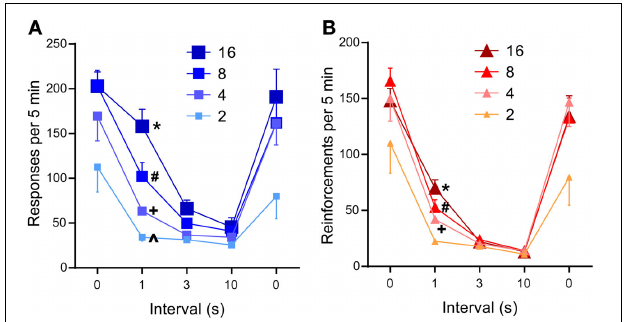
FIGURE 5 | Effects of inter-reinforcement interval on self-stimulation. (A) Mean lever-press rates are shown as a function of inter-reinforcement interval and pulse number. All 0-s interval values were significantly greater than respective 3- or 10-s interval values ( Ps < 0.001). * P < 0 . 001, significantly greater than its 3- and 10-s values, but not from its 0-s value; # P < 0 . 05, significantly greater than its 3- and 10-s values, but lower than its 0-s value; + , ∧ P < 0 . 001, not significantly different from its 3- and 10-s values, but lower than its 0-s value (B). Mean reinforcement rates are shown as a function of reinforcement interval and pulse number. All 0-s interval values were significantly greater than respective 1-, 3-, or 10-s interval values ( Ps < 0.001). * P < 0 . 001, significantly greater than its 3- and 10-s values; # , + P < 0 . 01, significantly greater than its 10-s values.